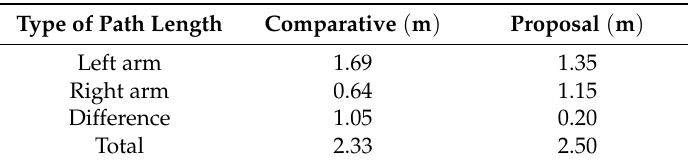
Table 2. Result of path